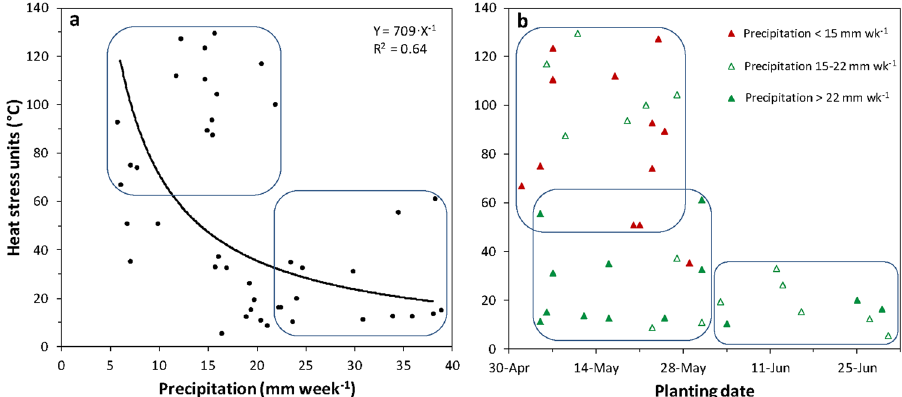
Figure 1. Heat stress units (accumulated daily maximum temperature in excess of 30 °C) as a function of ( a ) late critical period weekly precipitation and ( b ) planting date of corn. The upper box in 1a defines an area with heat units > 60 °C and precipitation < 22 mm wk − 1 , and the lower box defines an area with heat stress units < 60 °C and precipitation > 22 mm wk − 1 . The points in 1b are coded by precipitation categories displayed in the legend. Note that the top left box is composed mostly of points with low precipitation ( < 15 mm wk − 1 ), the lower left box of points with high precipitation ( > 22 mm wk − 1 ), and the lower right box of points with intermediate precipitation (15–22 mm wk − 1